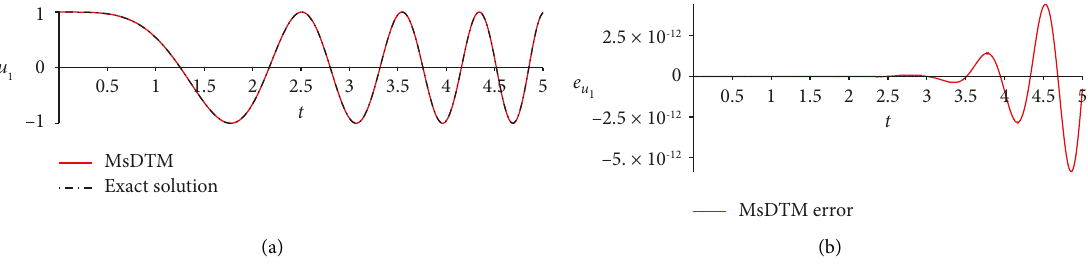
Figure 7: The approximate solution component u